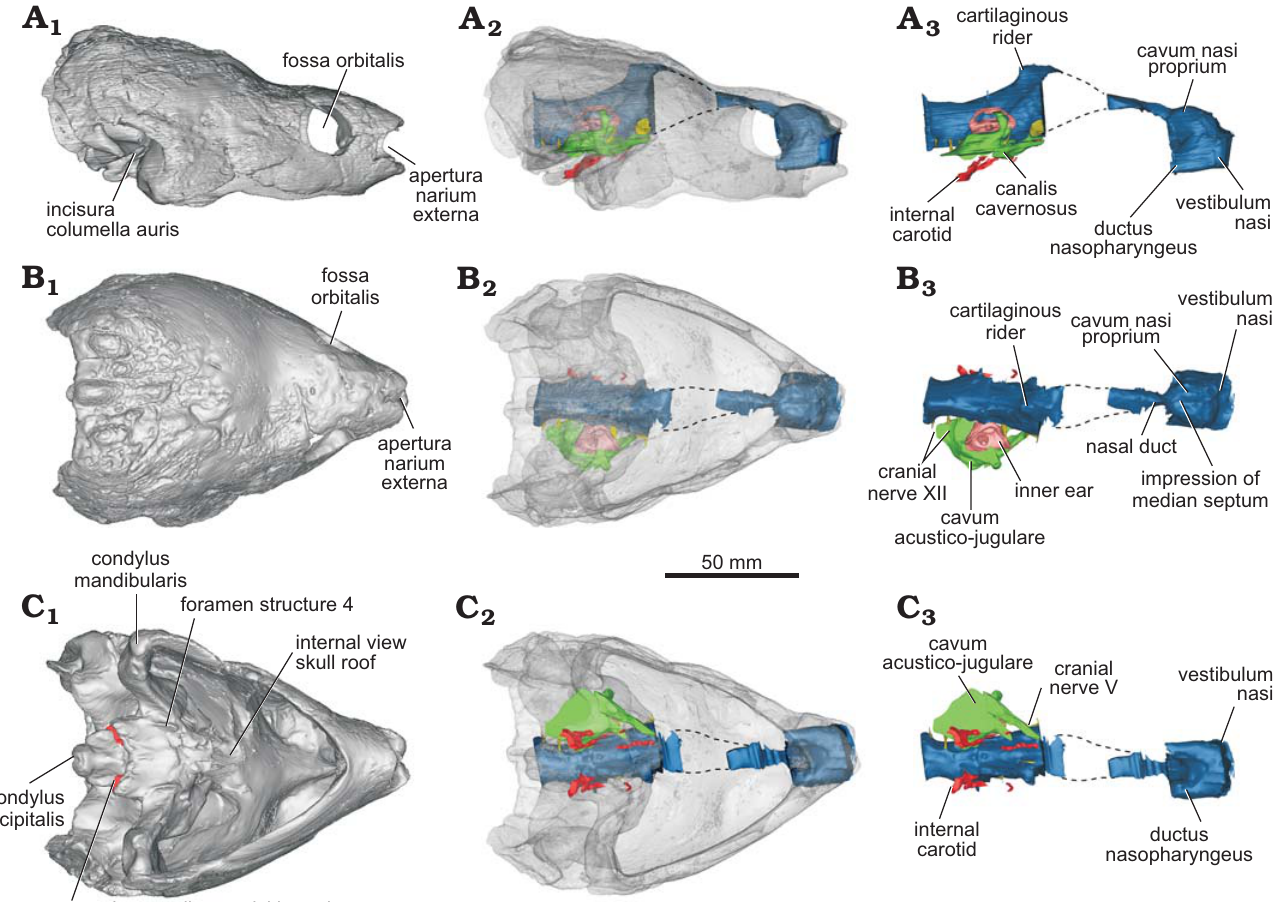
Fig. 1. Digitally rendered skull and endocranial anatomy of helochelydrid turtle Naomichelys speciosa Hay, 1908 (FMNH PR273) from the Early Cretaceous (Aptian/Albian) Trinity Group, Texas; in lateral (A), dorsal (B), and ventral (C) views. Surface reconstruction of the skull (A 1 –C 1 ), cranial endocast including brain, inner ear, canalis cavernosus, and nasal cavity in situ with the bone rendered semi-transparent to allow observation of internal structures (A 2 –C 2 ), isolated endocasts (A 3 –C 3